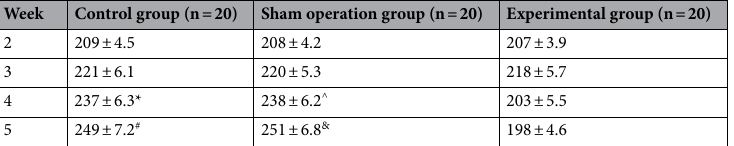
Table 2. Body mass (g). * P < 0.05 compared with the experimental group, # P < 0.05 compared with the experimental group, ^ P < 0.05 compared with the experimental group, & P < 0.05 compared with the experimental group. From the second week, the rats in experimental group began to eat less, and their body mass decreased obviously compared with that in control group and sham operation group. (SPSS22.0 http:// www.downx ia.com/downi nfo/16552